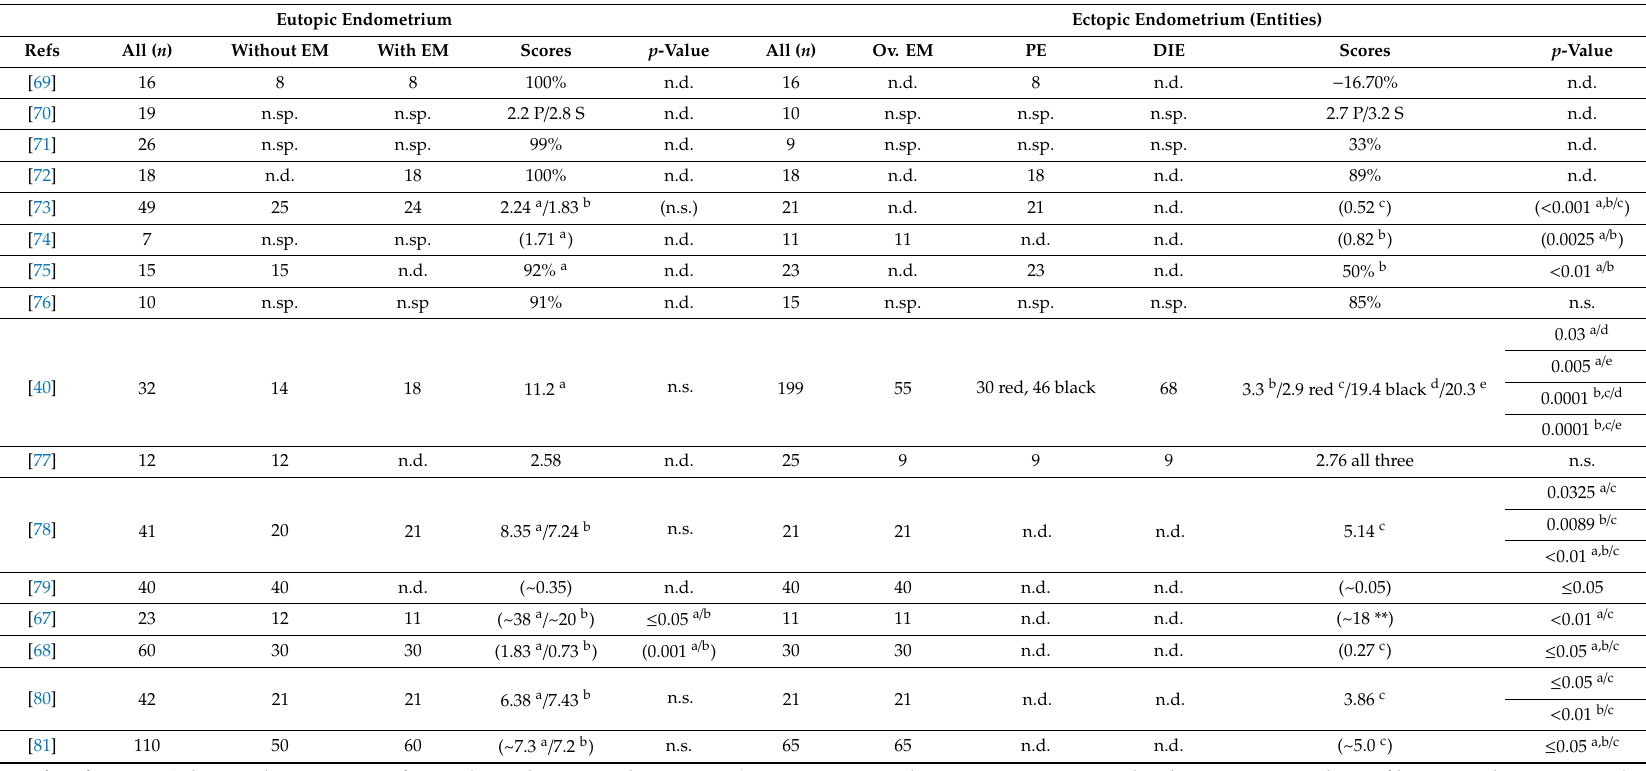
Refs, references; % denotes the percentage of stained samples; EM, endometriosis; Ov. EM, ovarian endometriosis; PE, peritoneal endometriosis; DIE, deep infiltrating endometriosis; n.d., not done; n.sp., not specified; n.s., not significant; P, proliferative; S, secretory. Superscript letters denote the statistical